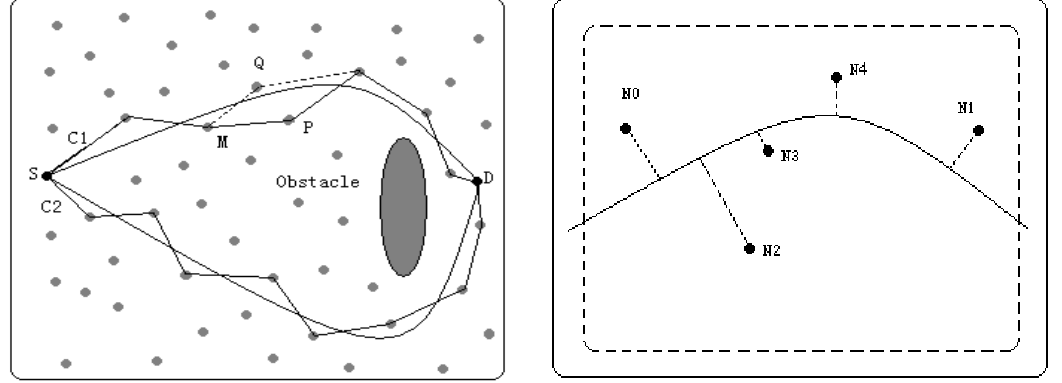
Figure 14. CBR model [45]. Figure 15. Next-hop selection